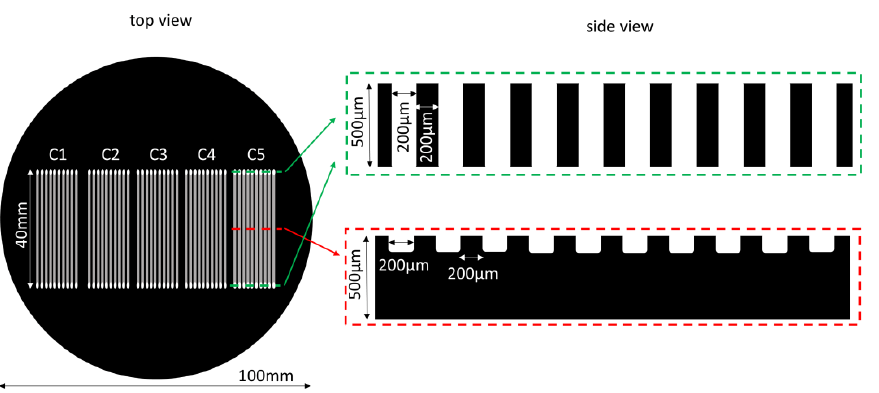
Figure 6. Design pattern for 5 microfluidic chips. Top view shows a panoramic view of the test pattern on the sample. Side view corresponds to transverse cuts at positions marked by dashed lines.